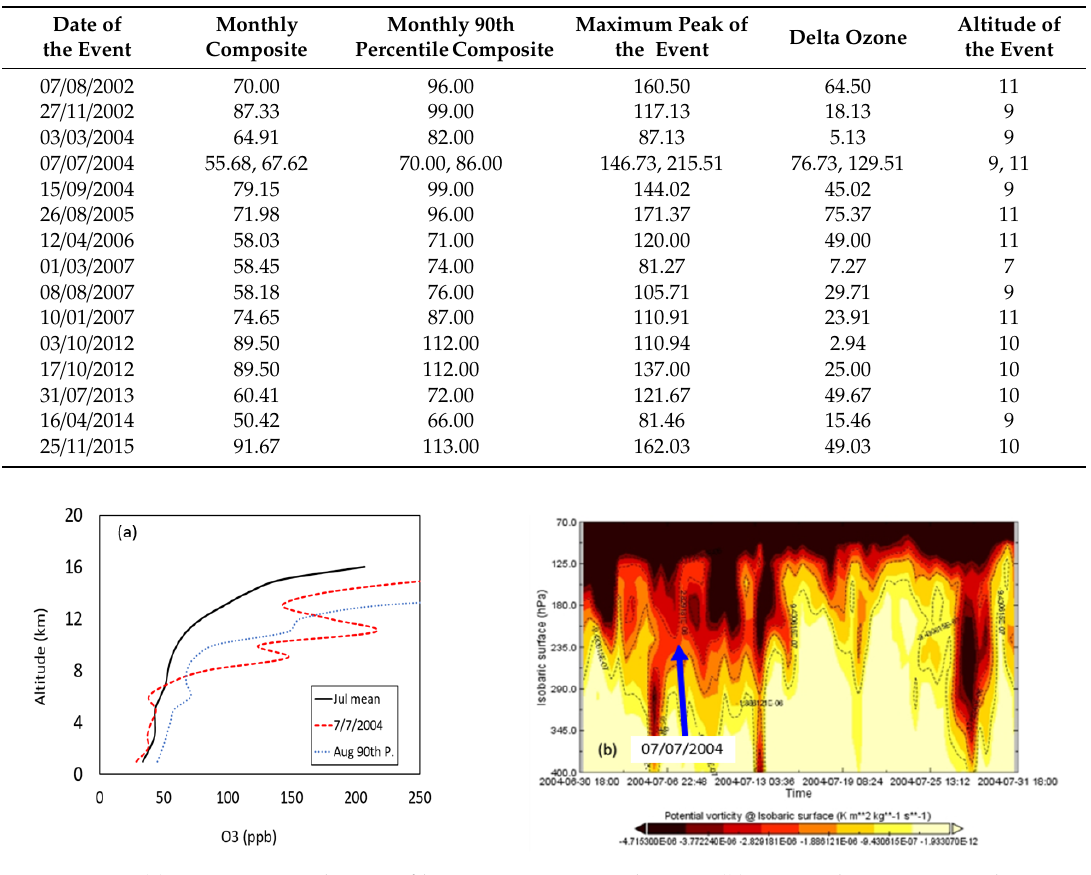
Table 2. Summary of high ozone (ppb) events statistics using 90th percentile and potential vorticity (2 PVU) as thresholds.